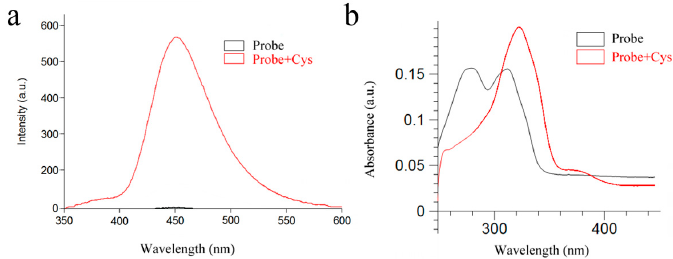
Figure 1. ( a ) The fluorescence intensity of the probe and the probe added to Cys-buffered solution (PBS (phosphate buffered solution):DMSO (dimethyl sulfoxide) = 6:4, pH = 7.4) at room temperature; ( b ) The absorption spectra of the probe and the probe added to Cys in buffered solution (PBS:DMSO = 6:4, pH = 7.4) at room temperature. λ ex = 325 nm.